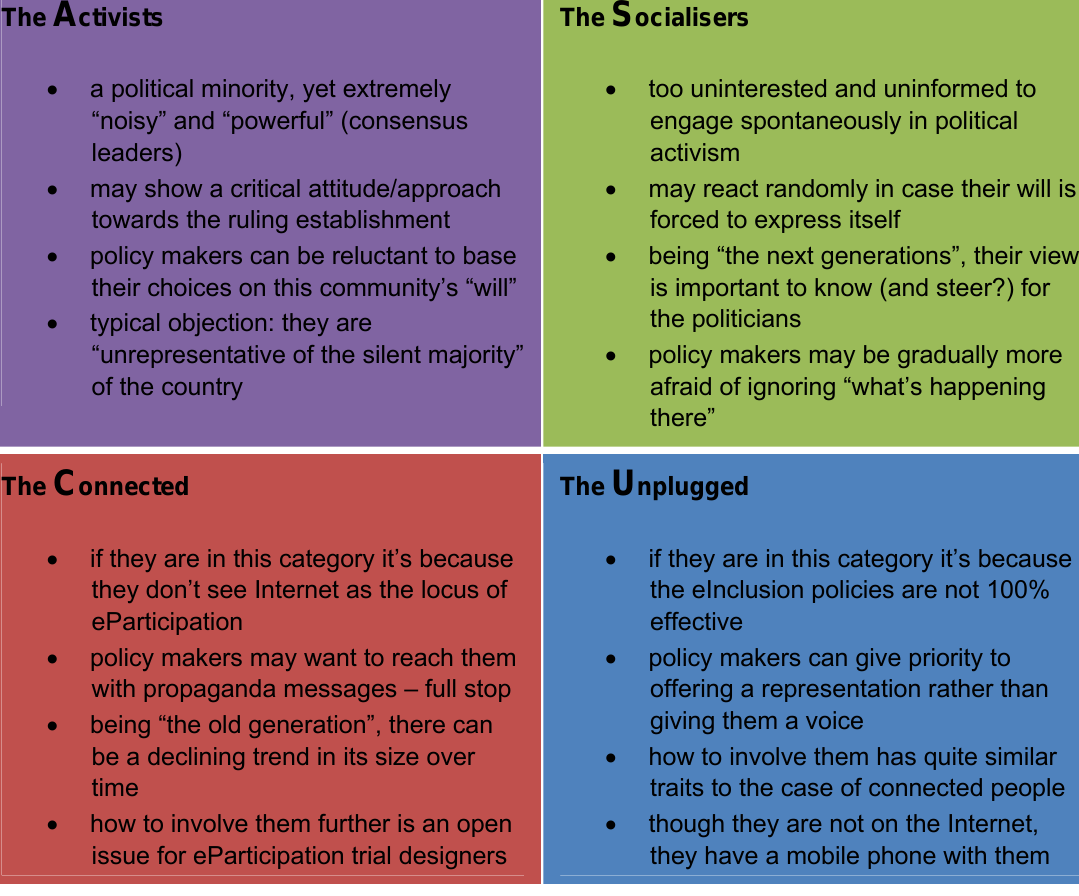
Table 3: A policy maker’s view of the ASCU communities The A